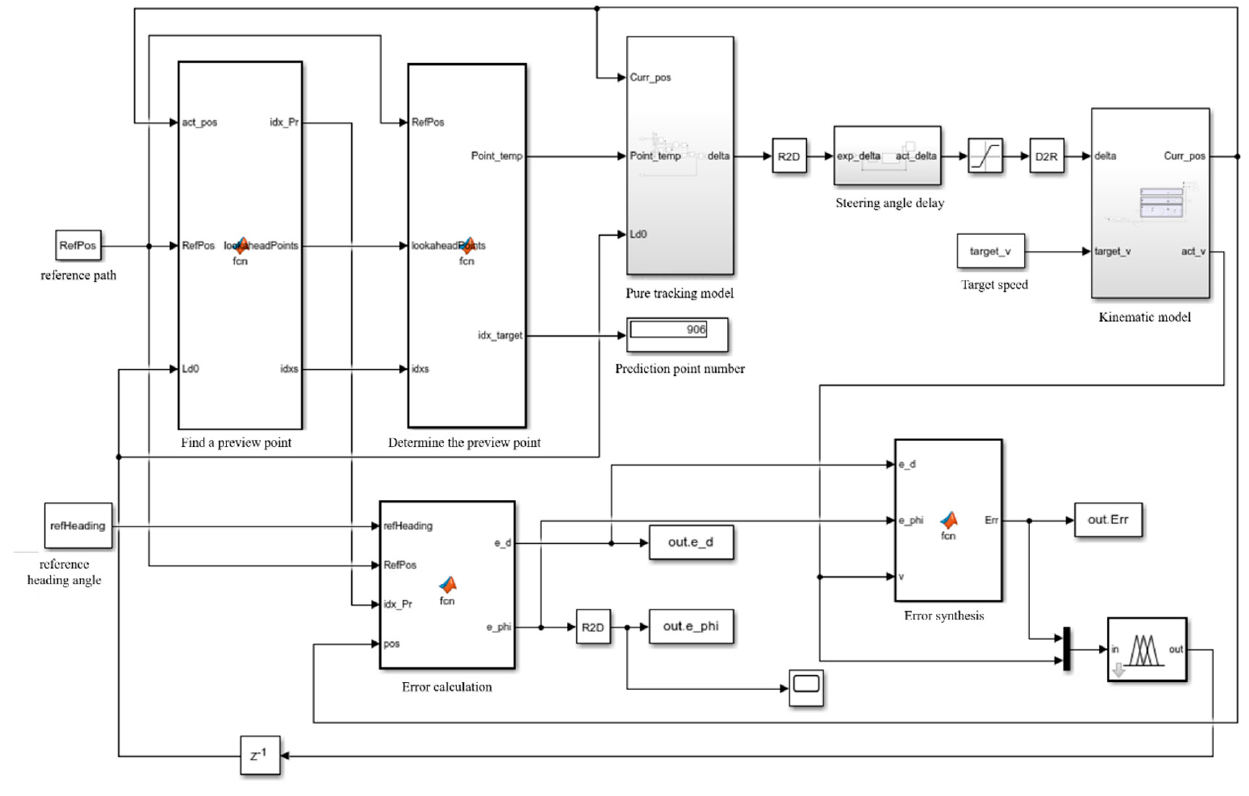
Figure 11. 4WS pure tracking algorithm simulation model.